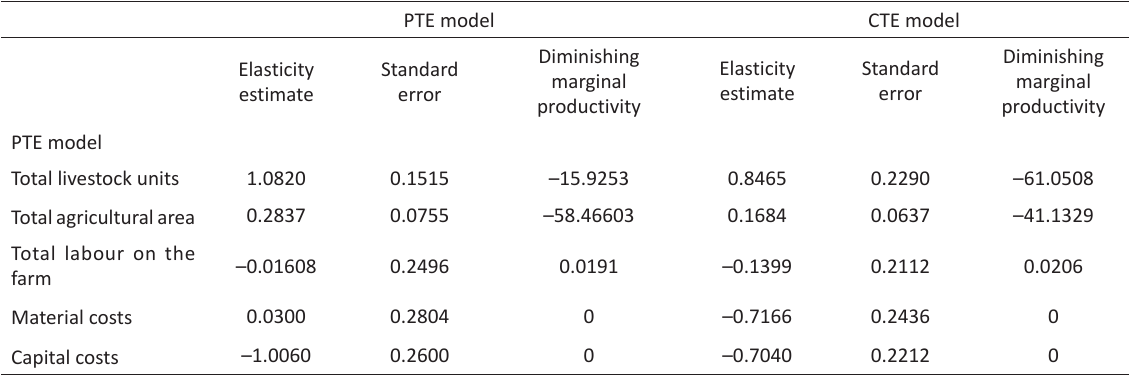
Table A2. Theoretical consistency of the pure technical efficiency (PTE) model and the compensated technical efficiency (CTE)